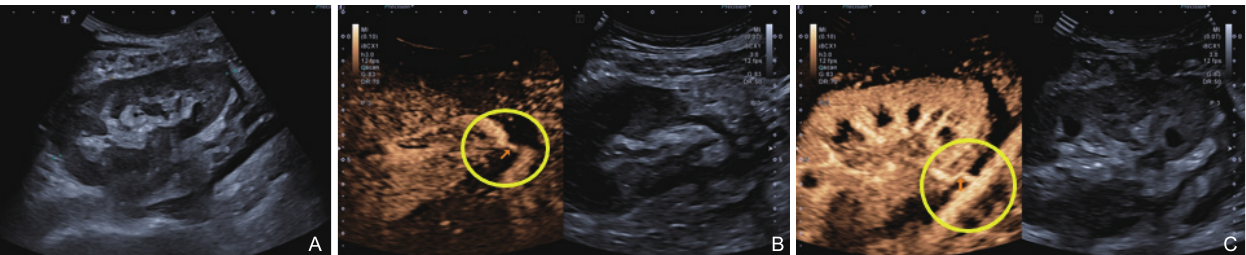
Figure 12 A 33-year-old male patient who had elevated creatinine for 4 years was diagnosed with chronic renal failure-uremic stage and underwent kidney transplantation. Ultrasound was performed 10 days after kidney transplantation with a creatinine of 130umol/L. (A) Gray-scale ultrasound showed that the size and shape of the transplanted kidney were average, and the demarcation between the cortex and medulla was clear; (B-C) Contrast-enhanced ultrasound showed a narrowed segment of the renal artery branch at the lower pole, with a diameter of about 0.3 cm, suggesting the presence of renal artery stenosis in the transplanted kidney.